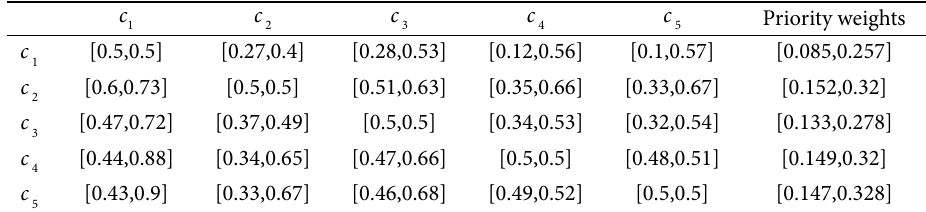
Table 1. Collective interval additive preference relations for five criteria and its priority weights c